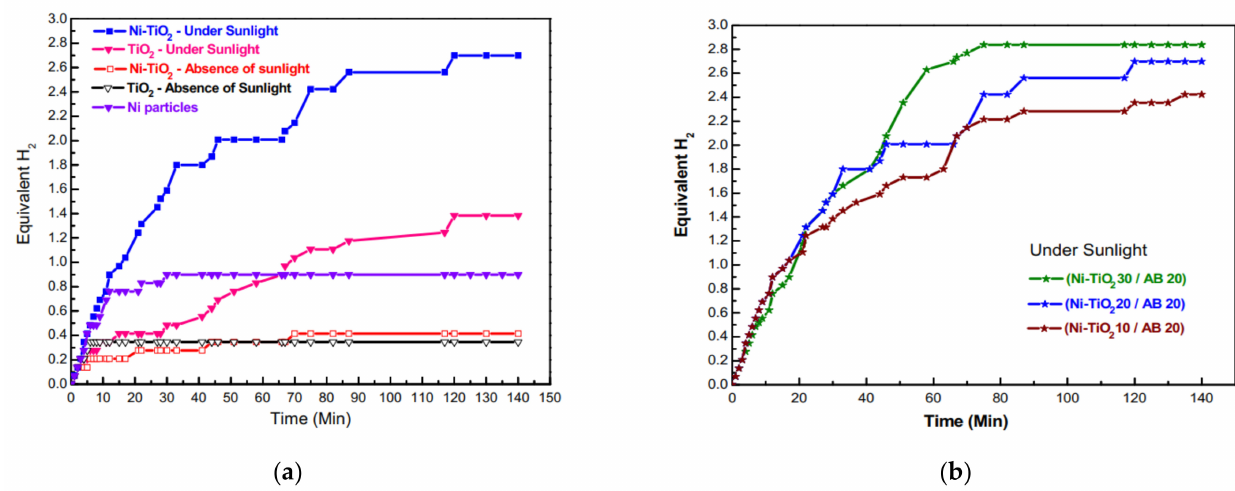
Figure 15. ( a ) Catalytic performance of Ni-TiO 2 NFs in the absence and presence of light for AB hydrolysis reaction; ( b ) Effect of metal concentration on H 2 generation. Reprinted from reference [103] with permission from